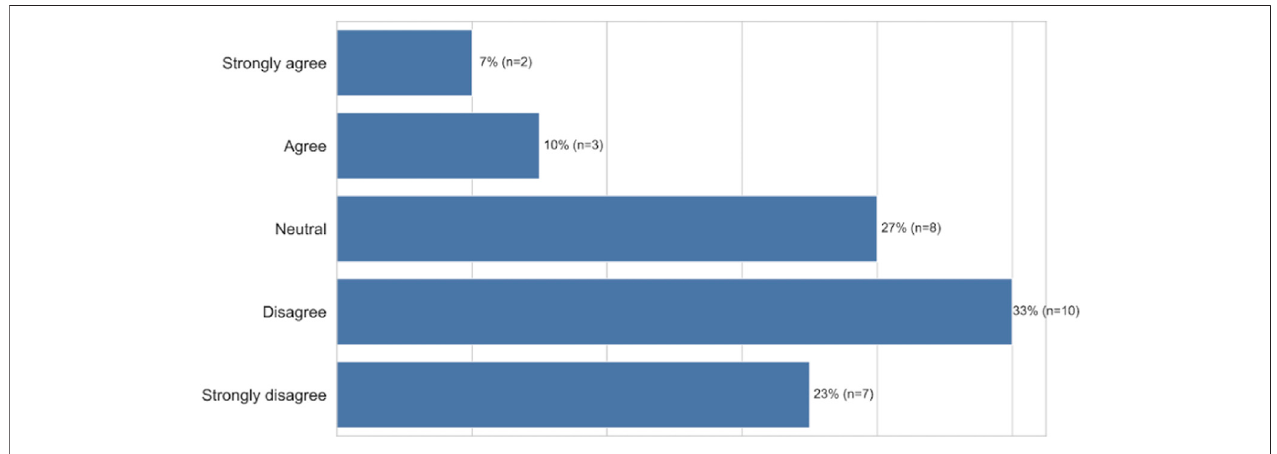
FIGURE 11 | African-American participants belief ASR technology will not improve for users like themselves ( n (cid:1) 30).